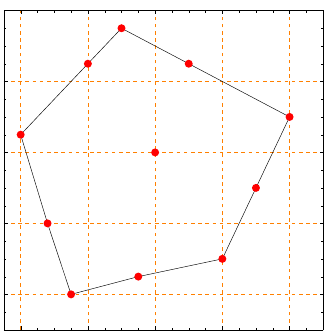
Figure 12. PS points close to those of the ones in [21].